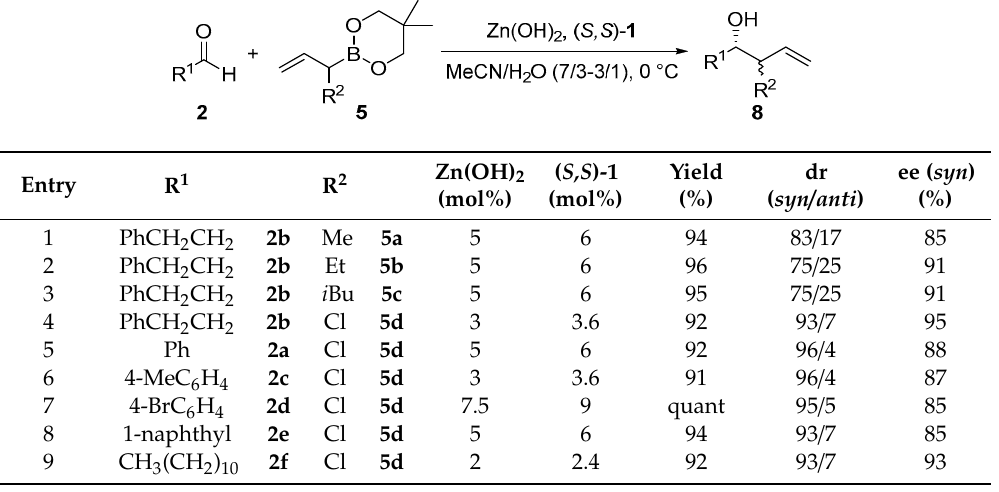
Table 2. Allylations of benzaldehydes 2 to 8 .